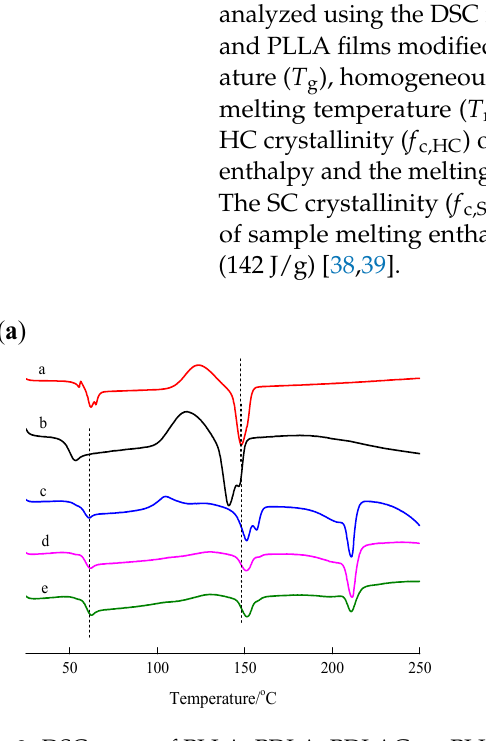
Figure 3. DSC curve of PLLA, PDLA, PDLAG, m-PLLA and m-PLAG samples. ( a ) a. PLLA; b. PDLA; c. m-PLLA-1; d. m-PLLA-2; e. m-PLLA-3; ( b ) a. PLLA; b. PDLAG; c. m-PLAG-1; d. m-PLAG-2; e. m-PLAG-3. Table 2. DSC and TGA Thermal properties, crystallinity of polymer samples table. Sample Modification Time/min T m, HC /°C